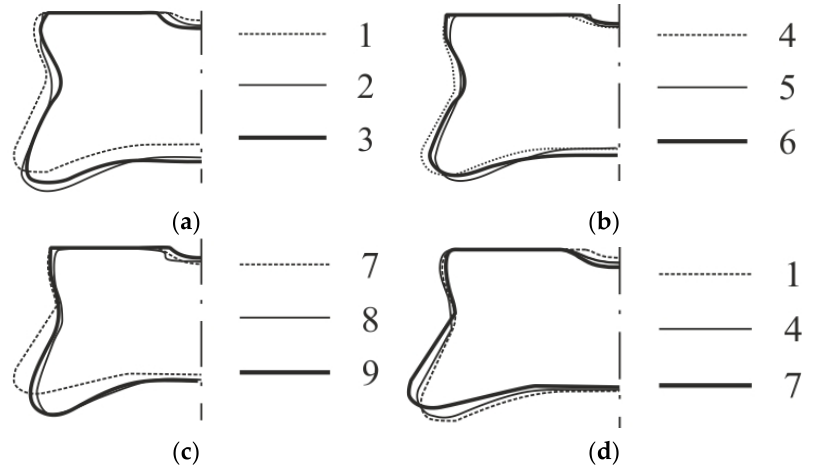
Figure 19. The rivets profiles for sheet arrangements in accordance with Table 2: ( a ) no.1, 2 and 3, ( b ) no.4, 5 and 6, ( c ) no.7, 8 and 9, ( d ) no.1, 4 and 7.